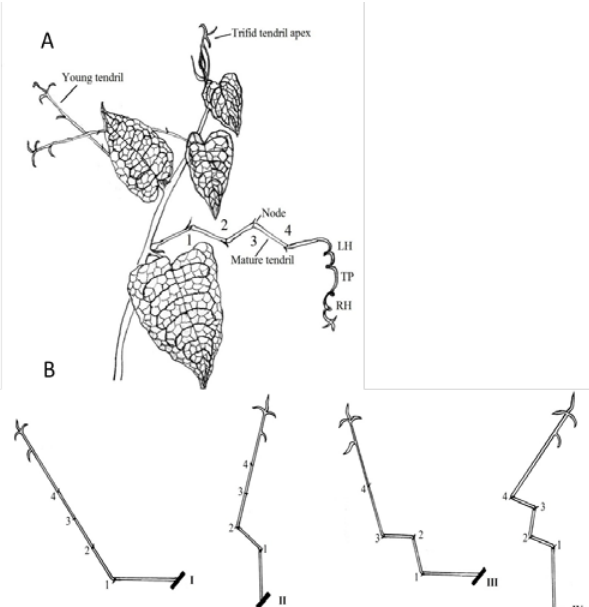
Fig. 4. The zig-zag pattern of tendrils in Antigonon leptopus Each tendril has four nodes. A. The twig with tendril (the young upper tendrils are without any turn). The lower mature tendril has alternate turns (1-4). B. The developmental stages of turns (I-IV) in maturing tendril. The abbreviations LH, TP and RH stand same as in figure 5